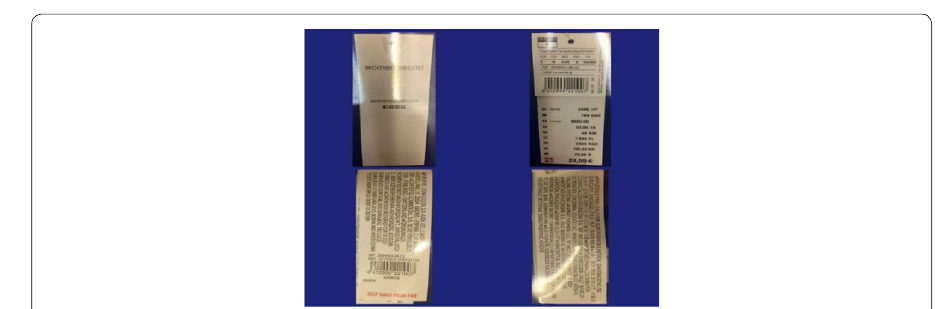
Fig. 7 Bimba & Lola